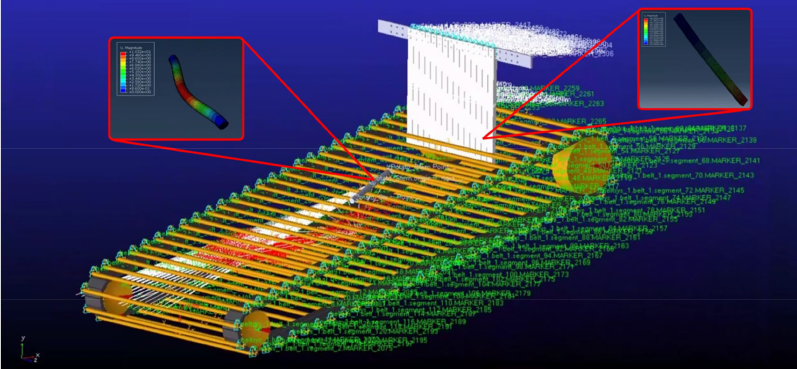
Figure 6. Rigid-flexible coupling simulation model of stem transported-posture adjustment